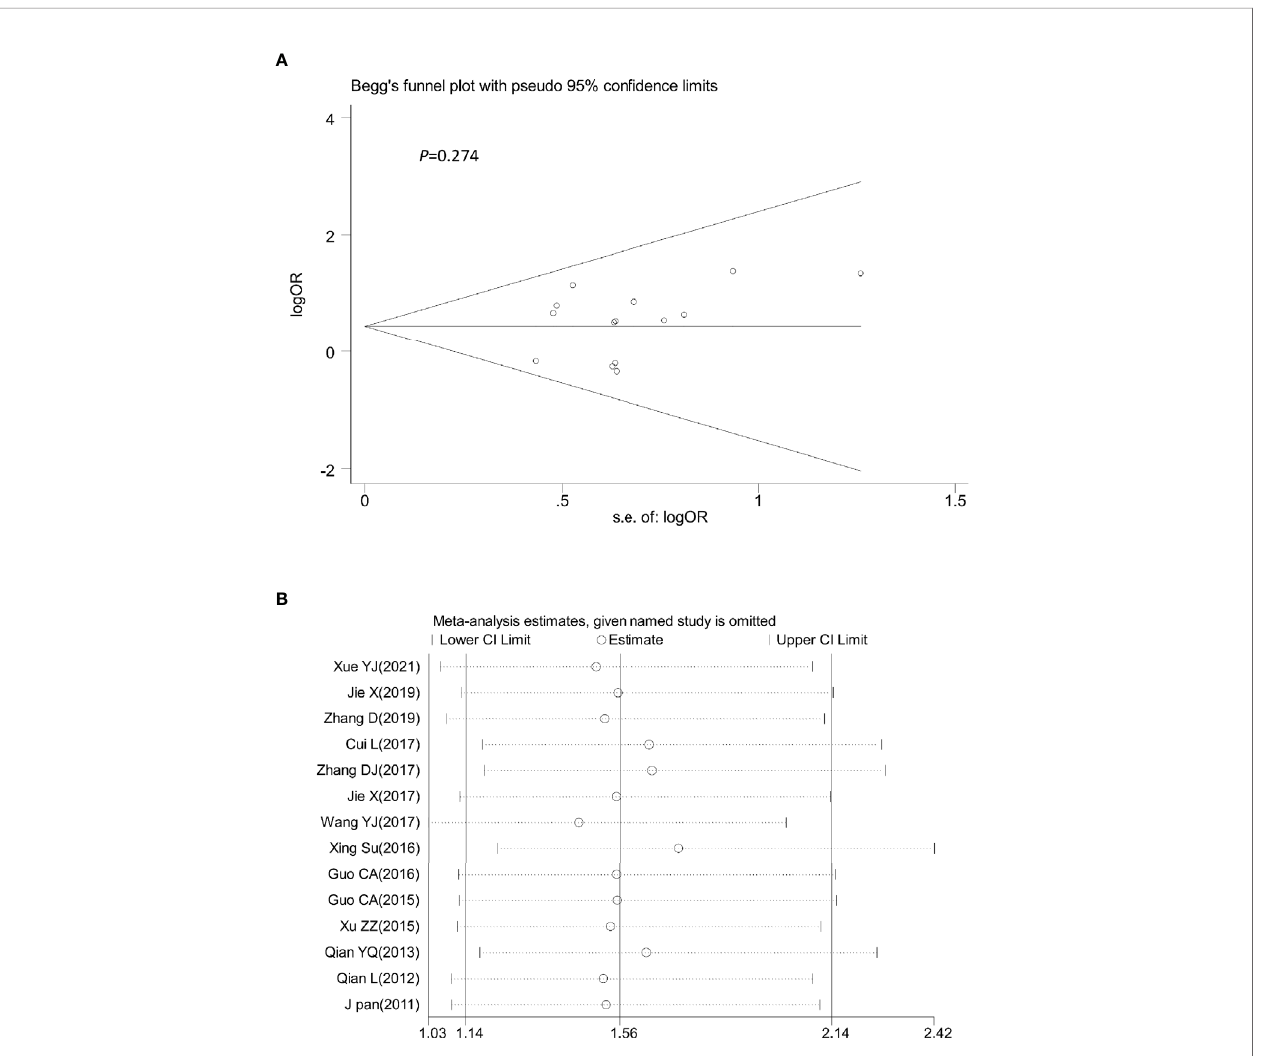
FIGURE 10 | Begg ’ s funnel plot (A) and sensitivity analysis (B) of all the included studies for the analysis of PR. Begg ’ s test (p = 0.274). PR, partial